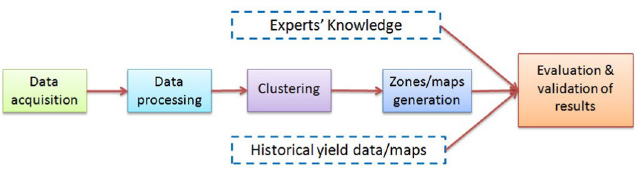
Fig. 6 The delineation management zones